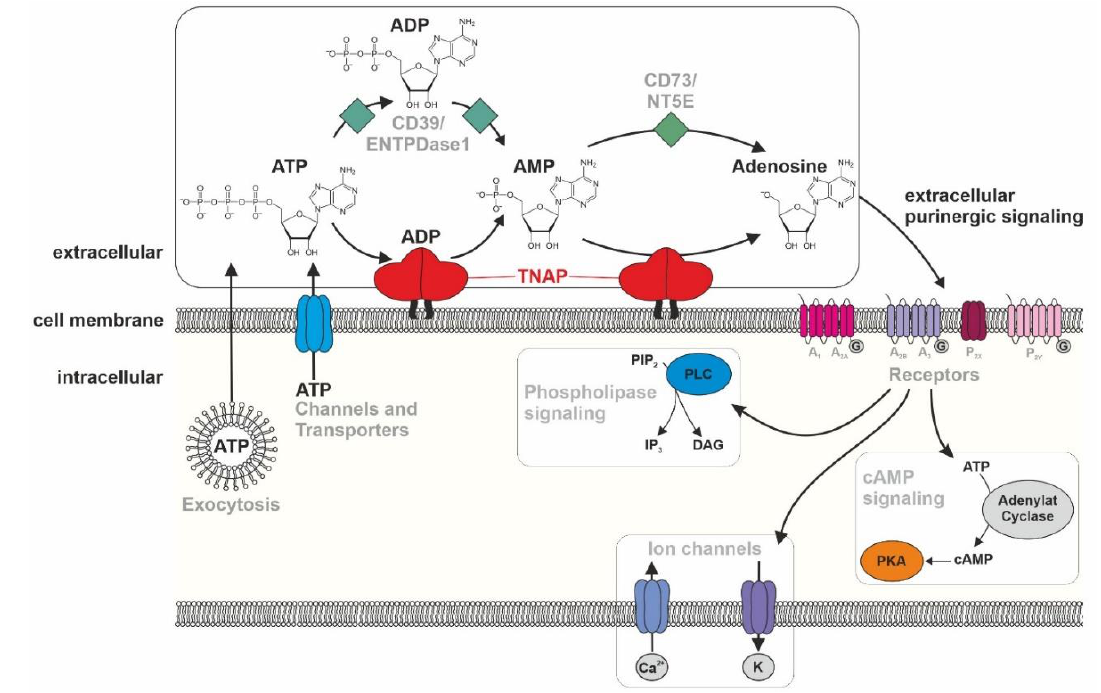
Figure 3. The role of TNAP within the purinergic signaling. ATP/ADP/AMP : adenosine tri-/die-/monophosphate, cAMP: cyclic adenosine monophosphate, DAG: diacylglycerol, CD39/ENTPDase1: ectonucleoside triphosphate diphosphohydrolase 1, IP 3 : Inositol trisphosphate, CD73/NT5E: ecto-5′-nucleotidase, PIP 2 : phosphatidylinositol 4,5-bisphosphate, PKA: phosphokinase A, PLC: phospholipase C, TNAP: tissue-nonspecific alkaline phosphatase.